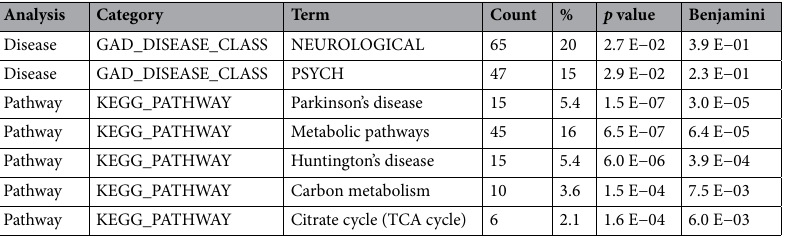
Table 2. Top 5 “Disease” and “pathway” terms enriched by DAVID Knowledge analysis 21 . Disease and KEGG pathways 23 with Fisher’s Exact Test based p value < 0.05 were